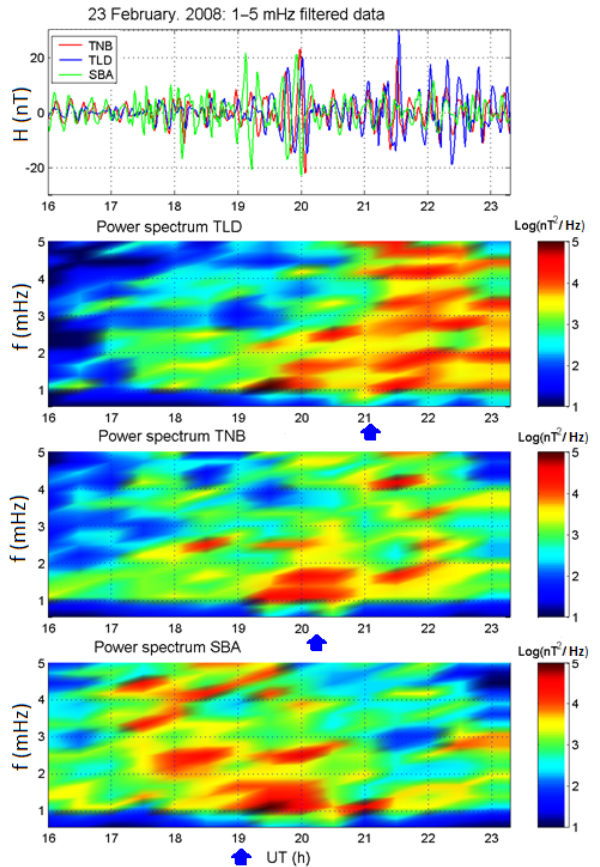
Figure 8. From top: variations in the geomagnetic field H compo- nent filtered in the 1–5mHz frequency range and dynamical power spectra for the event on 28 February 2008. The arrows indicate MLT noon at the three stations.